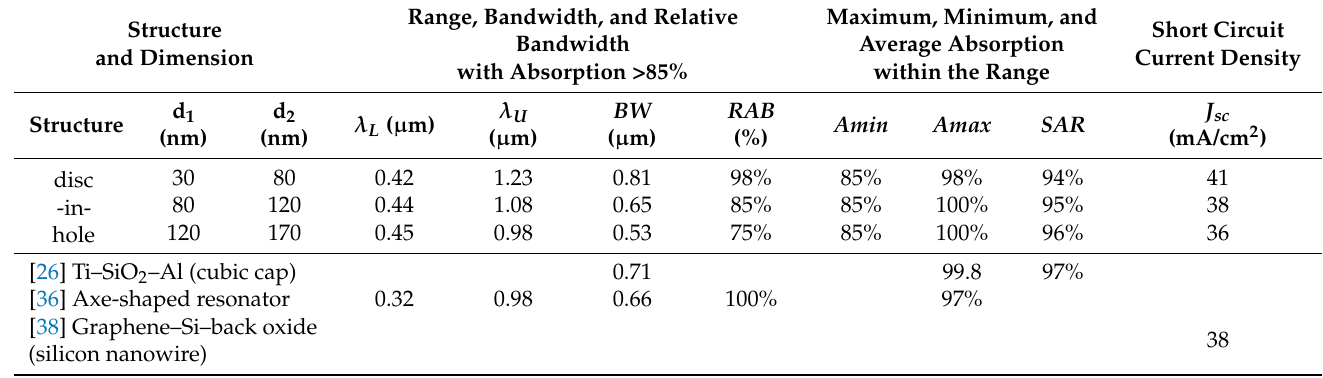
Table 1. Absorption properties of the proposed absorber and some related